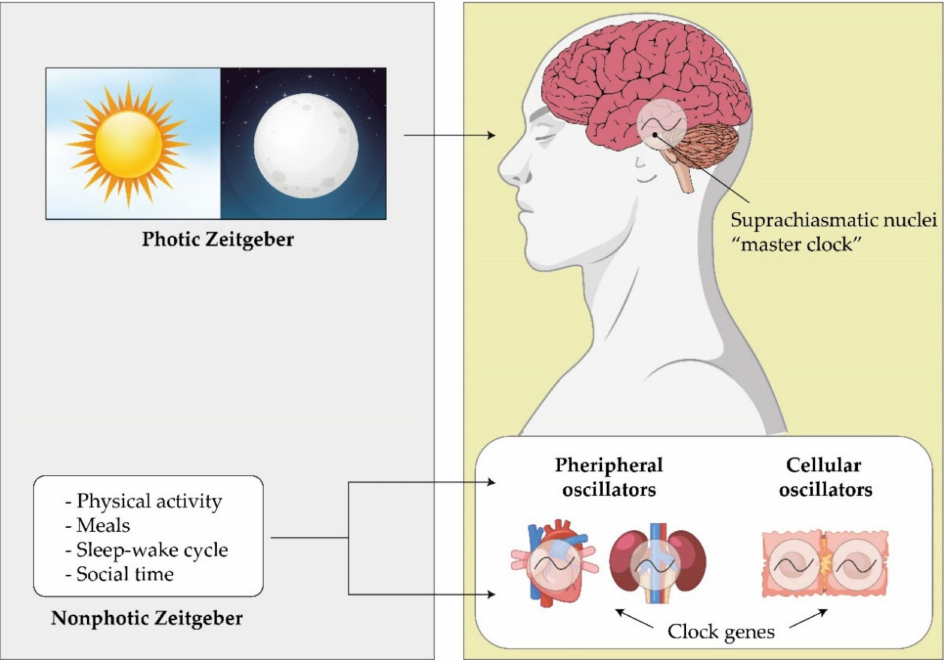
Figure 2. Photic and nonphotic zeitgebers in humans and their role on the circadian clock, which consists of peripheral and cellular oscillatory systems. The image was created with the Adobe Illustrator CC (Version 23.0.1.; Adobe Inc., 2019)